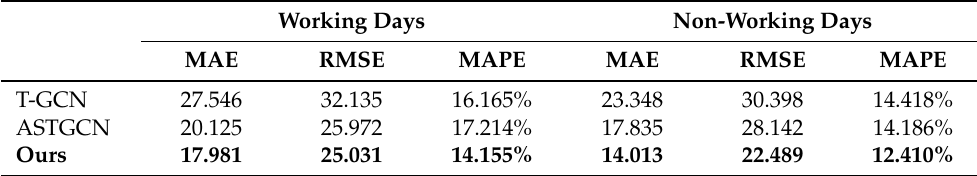
Table 3. Performance comparison of working days and nonworking